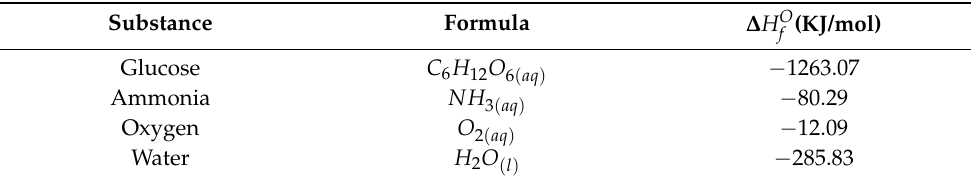
Table 2. Heat of formation at 298.15 K and 1 atm (101,325 kPa) of reference compounds used for the heat of combustion calculation during this study